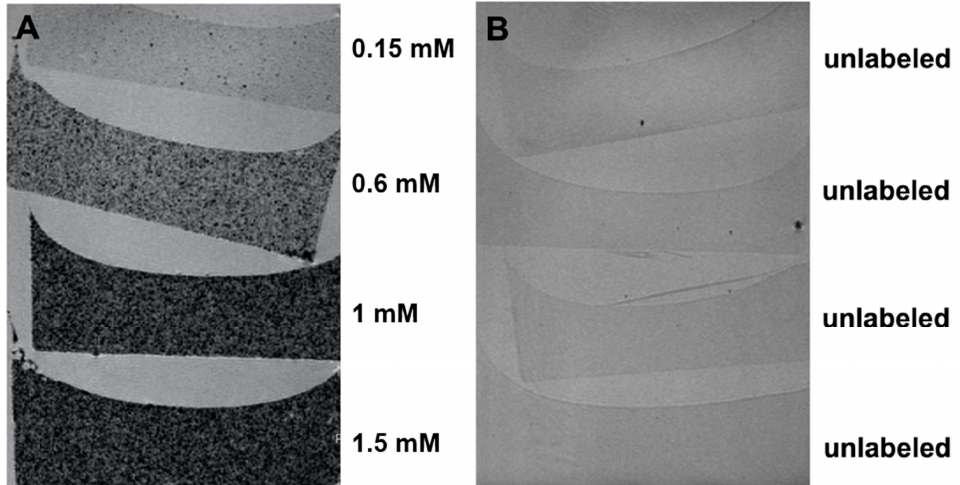
Figure 2. High-resolution MR imaging: ( A ) Magnetic resonance (MR) images of VSOPs-labeled hASCs seeded in agarose gel show the typical hypointense dark spots due to the signal decrease by iron oxide particles. The signal intensity is directly proportional to the concentration of VSOPs used for the labeling procedure. ( B ) The single hypointense spots in the gels with the unlabeled hASCs correspond to microscopic air bubbles located within or at the surfaces of the agarose gels.